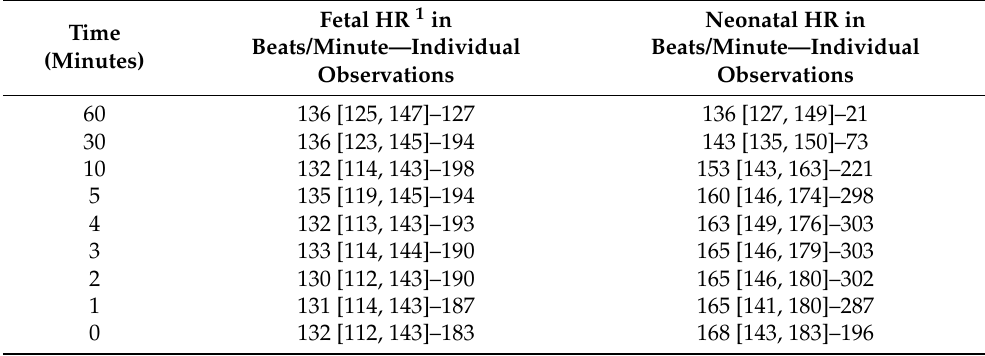
Table 2. Median heart rate at different time points and number of individual heart rate observations included.